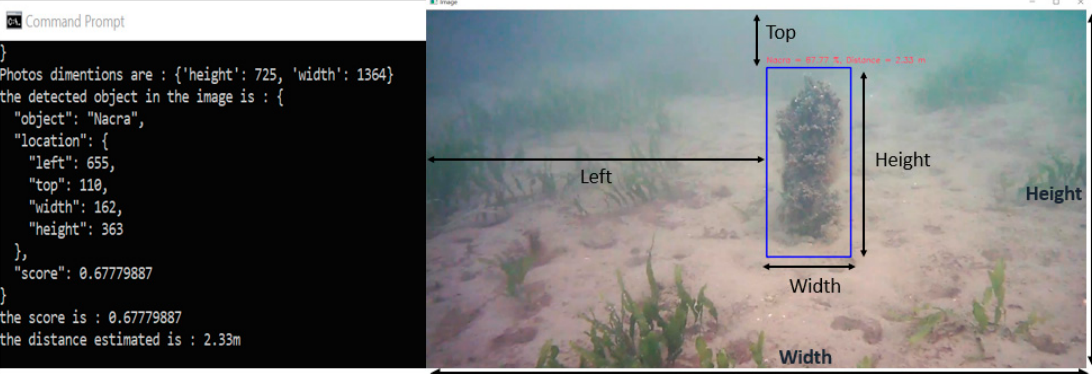
Figure 7. New specimen detection using the IBM Python API.